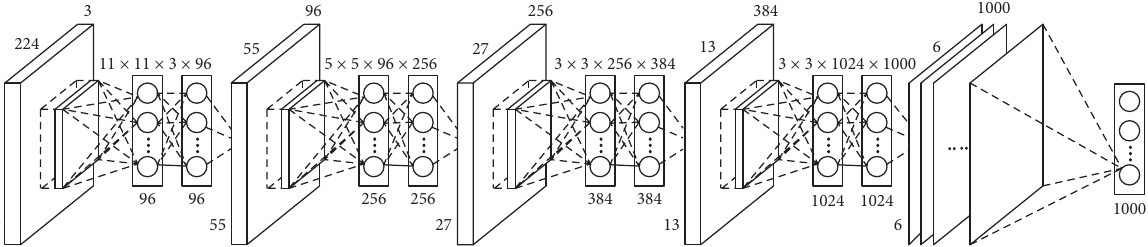
Figure 2: Structure and specific parameter settings of